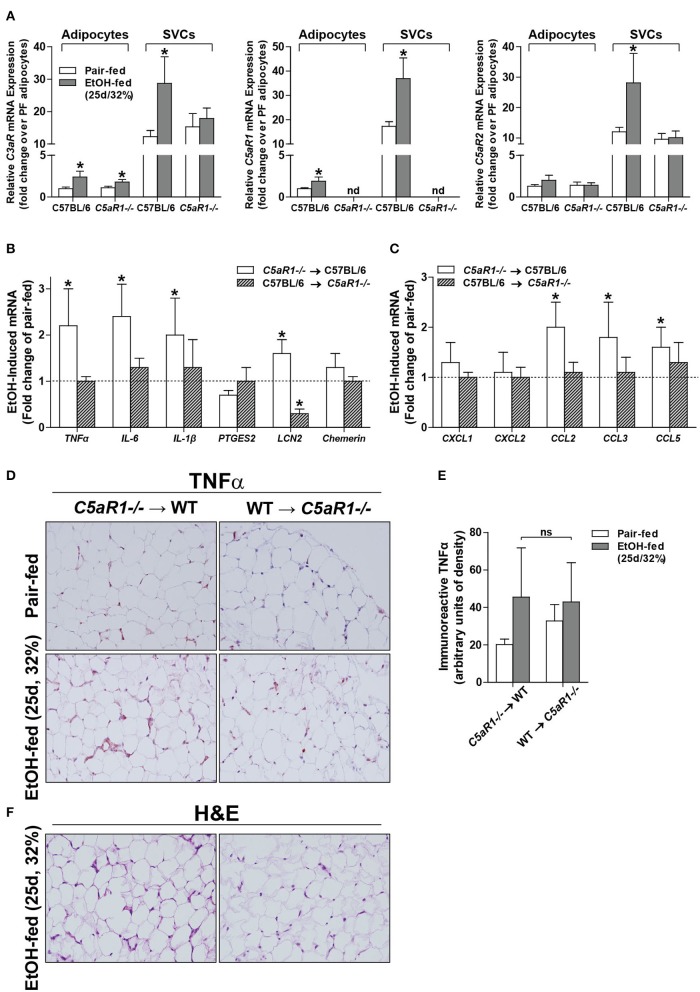
Non-myeloid C5aR1 expression modulates ethanol-induced adipokine expression in gonadal adipose tissue after chronic ethanol feeding in mice. WT and C5aR1−/− mice were allowed free access to ethanol (32%, d25) or pair-fed control diets. Adipocytes and stromal vascular cells (SVCs) were isolated following collagenase digestion. (A) Expression of mRNA for anaphylatoxin receptors in adipocytes and SVCs. Data are represented as fold change of genotype pair-fed adipocyte expression; nd, not detected. Values represent means ± SEM, values with * were significantly different from pair-fed controls within genotype of each respective cell type (P<0.05). n = 4–8 pair-fed and 6–12 EtOH-fed mice. (B–E) Chimeras were generated via transplantation of WT or C5aR1−/− bone marrow into C5aR1−/− and WT recipients, respectively. Chimeric mice were allowed free access to ethanol (32%, d25) or pair-fed control diets. Expression of mRNA for (B) adipokines, cytokines and (C) chemokines in gonadal adipose tissue. Values are expressed as the fold increase over genotype pair-fed controls. Values represent means ± SEM, values with * were significantly different from pair-fed controls within genotype (P<0.05). n = 3 for pair-fed and n = 4 EtOH-fed mice. (D) Paraffin-embedded gonadal adipose sections were deparaffinized followed by immunodetection of TNFα. Nuclei were counterstained with hematoxylin. (E) TNFα-stained areas were quantified from at least three images per slide using Image-Pro Plus software. Values represent means ± SEM, ns = not significant between ethanol-fed groups. N = 3 for pair-fed and EtOH-fed mice. (F) Paraffin embedded gonadal adipose sections were deparaffinized followed by staining for hematoxylin and eosin. All images (at least three images/slide) were acquired using a 20 × objective; images are representative of 3–4 mice/group.